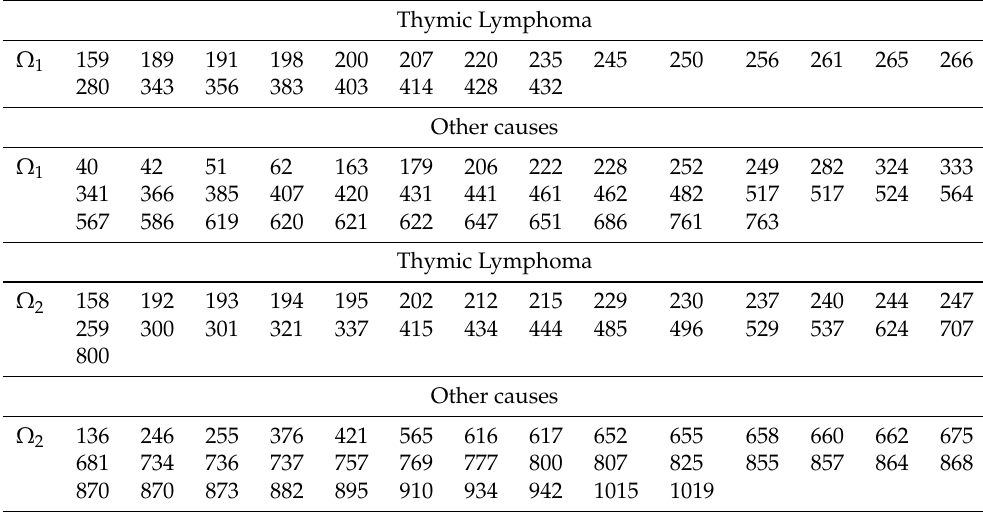
Table 5. Two groups of failure for the laboratory radiation male mice Ω 1 and Ω 2